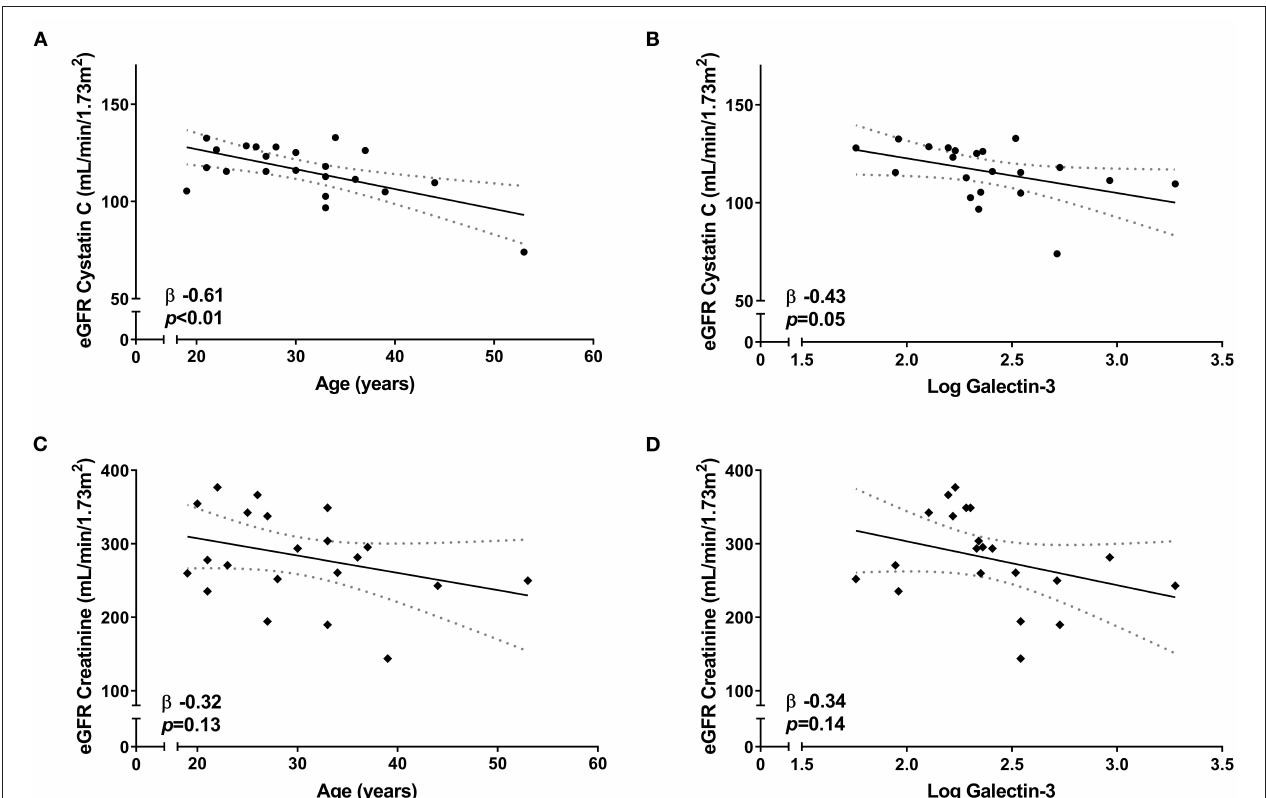
FIGURE 2 | Correlation between eGFR and renal parameters in Duchenne and Becker muscular dystrophy patients. Linear regression [95% CI] showing the correlation of Cystatin C-based eGFR with (A) age and (B) galectin-3 levels. Linear regression [95% CI] showing the correlation of creatinine-based eGFR with (C) age and (D) galectin-3